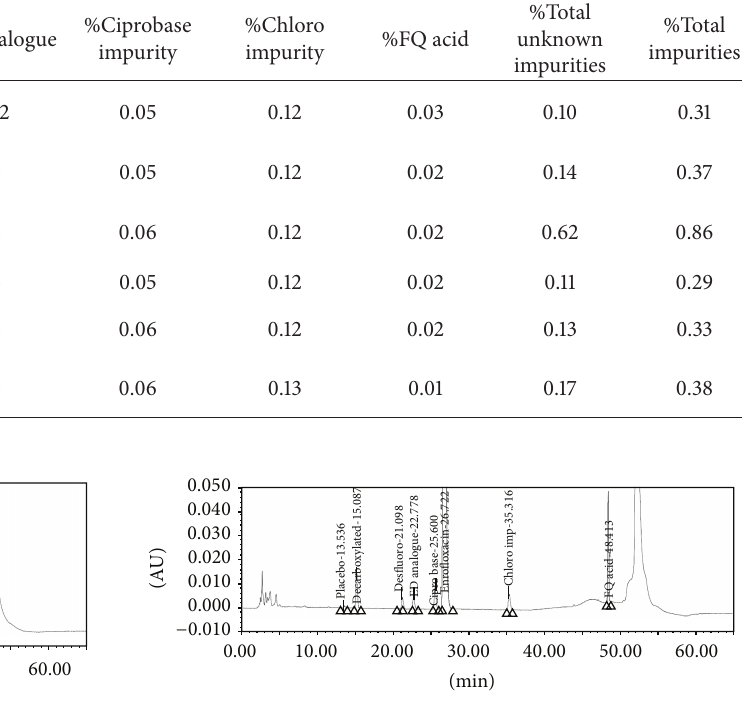
Table 6: Degradation data of EFX tablets.